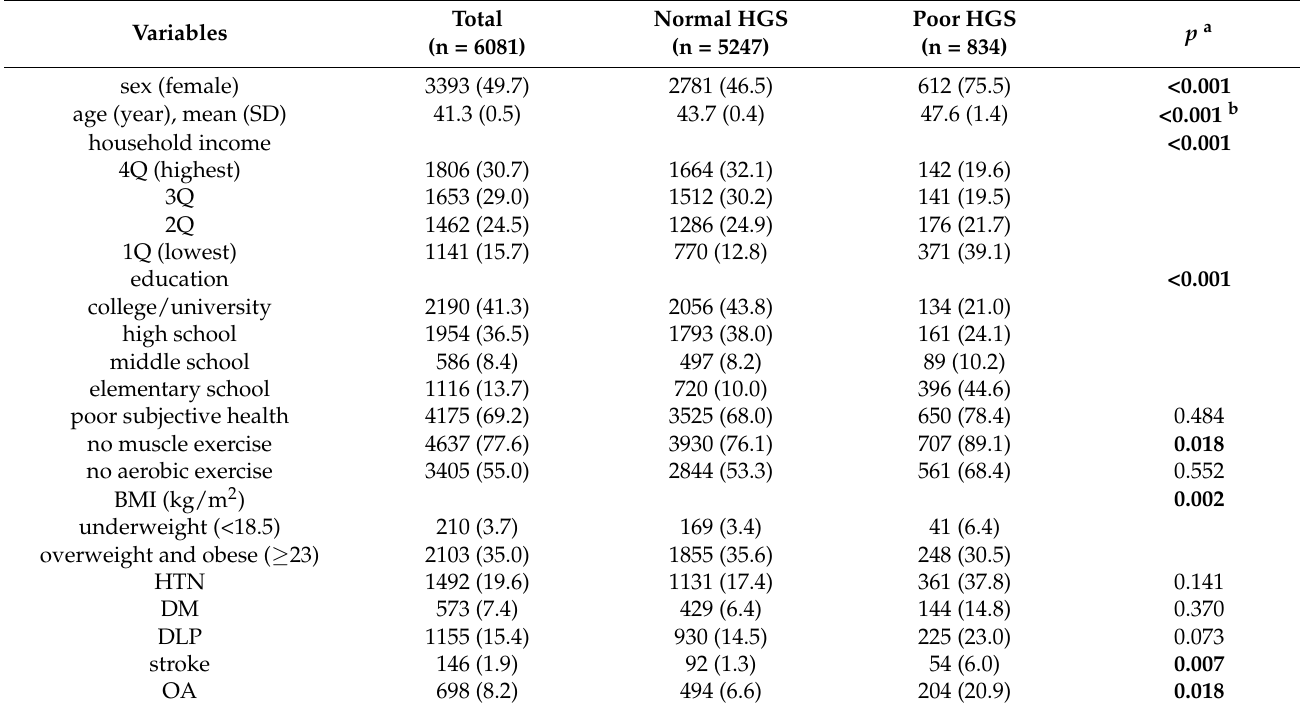
Table 1. Demographic characteristics of the study participants according to grip strength.